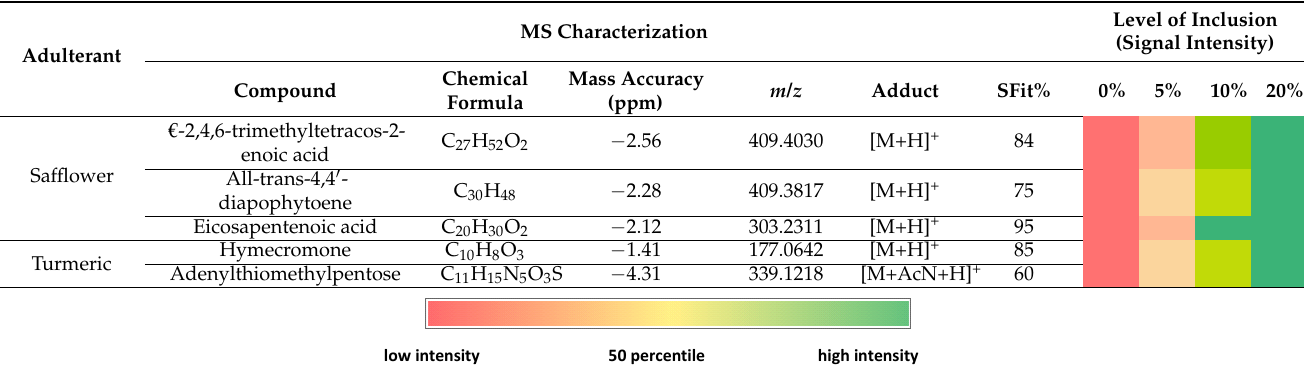
Table 2. Candidate marker compounds to discriminate between saffron pure and adulterated with safflower or turmeric at different inclusion levels (0, 5, 10 and 20%).